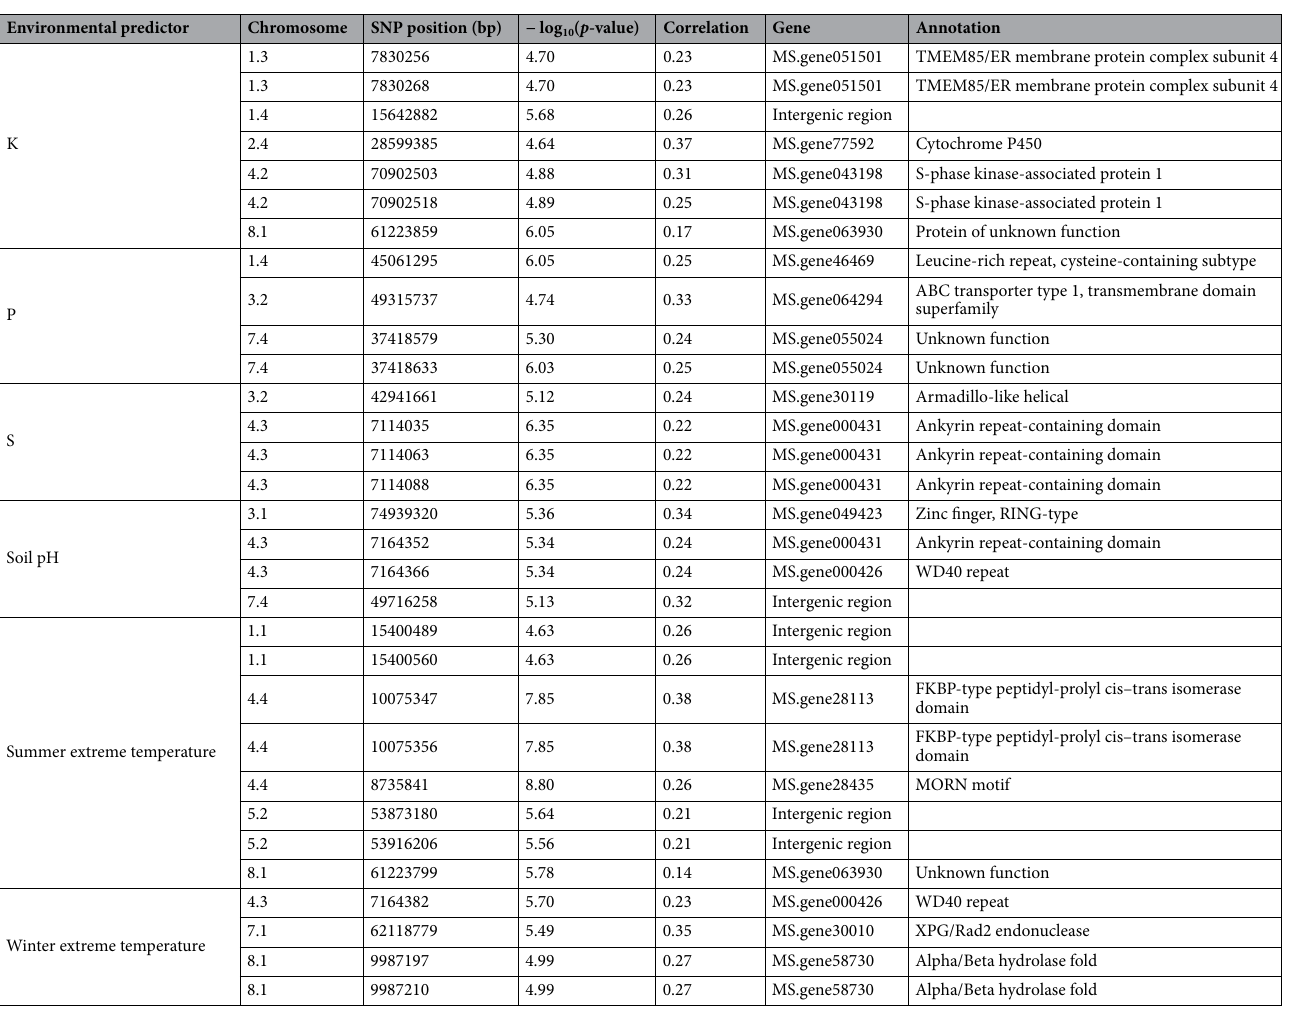
Table 5. Candidate genes associated with six environmental factors of long-term grazing sites detected by redundancy analysis